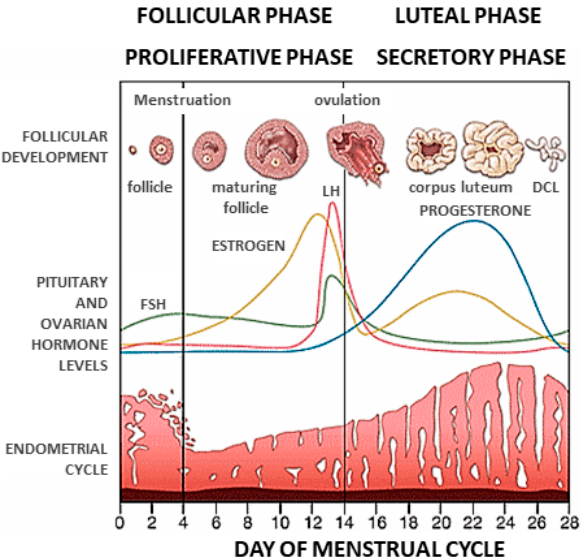
Figure 1. Diagram of the menstrual cycle showing the ovarian (follicular and luteal) and endometrial (proliferative and secretory) phases. The days of the menstrual cycle represent average values; durations and values may differ between different females or different cycles. DCL: degenerate corpus luteum; FSH: follicle-stimulating hormone; LH: luteinizing hormone.